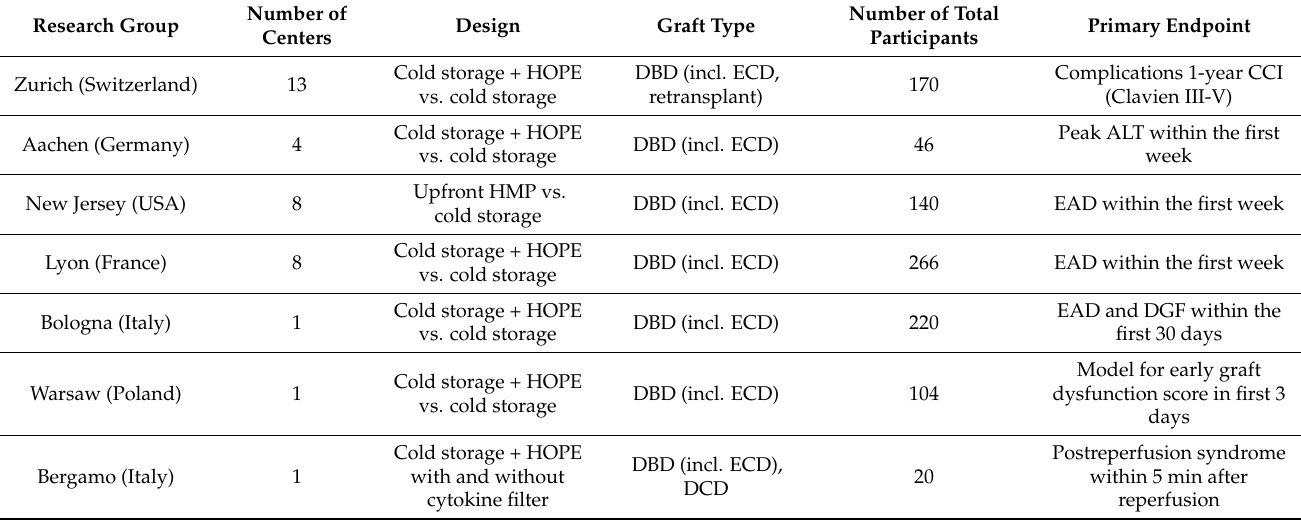
Table 2. Ongoing RCTs on the impact of HMP on outcomes after liver transplantation. The majority finished (or nearly finished) recruitment and results are expected within the next 12–24